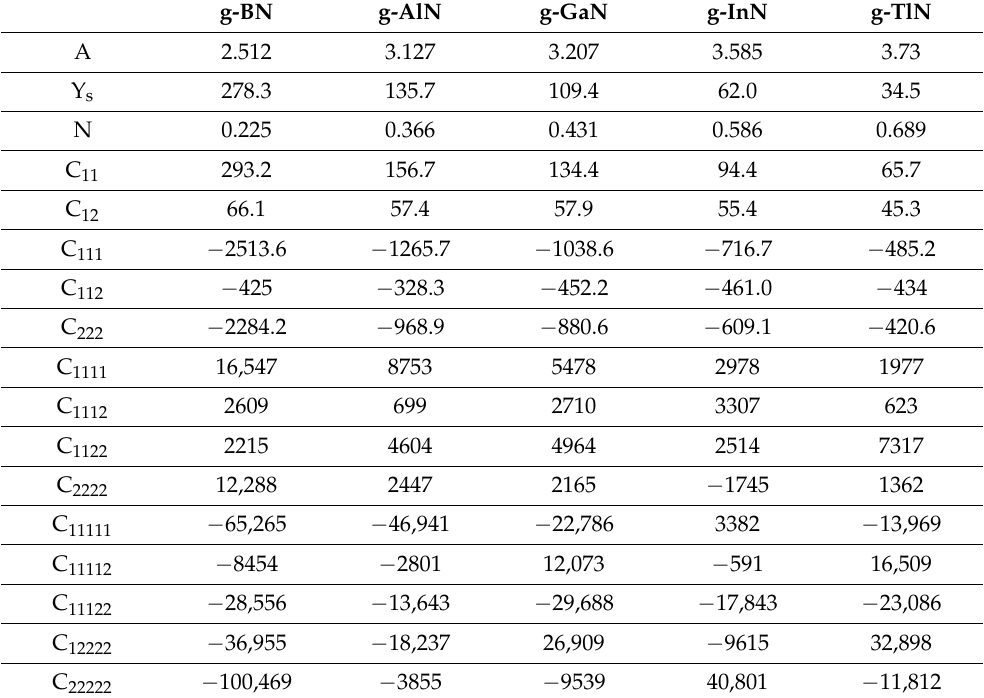
Table 3. Non-zero independent components for the SOEC, TOEC, FOEC, and FFOEC tensor compo- nents, Poisson’s ratio n, and in-plane stiffness Y s of g-AlN from DFT calculations, compared with g-BN, graphene, and graphyne. g-BN g-AlN